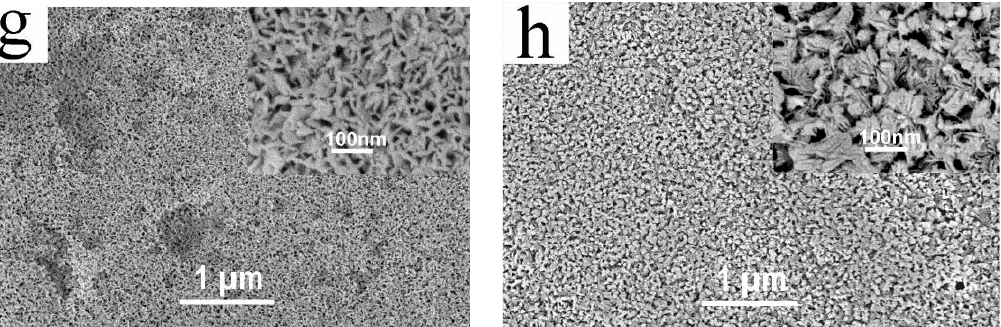
Figure 4. Surface morphology of the aluminum sheets after reacting with water vapor at different temperatures: ( a ) 300 °C; ( b ) 400 °C; ( c ) 500 °C; ( d ) 600 °C; ( e ) 700 °C; ( f ) 800 °C; ( g ) 900 °C; ( h ) 1000 °C.